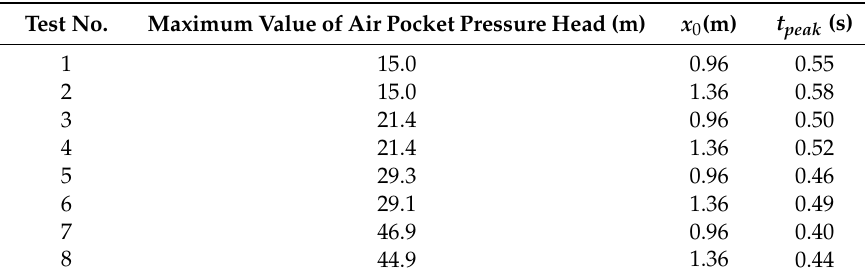
Table 2. Summary of experimental